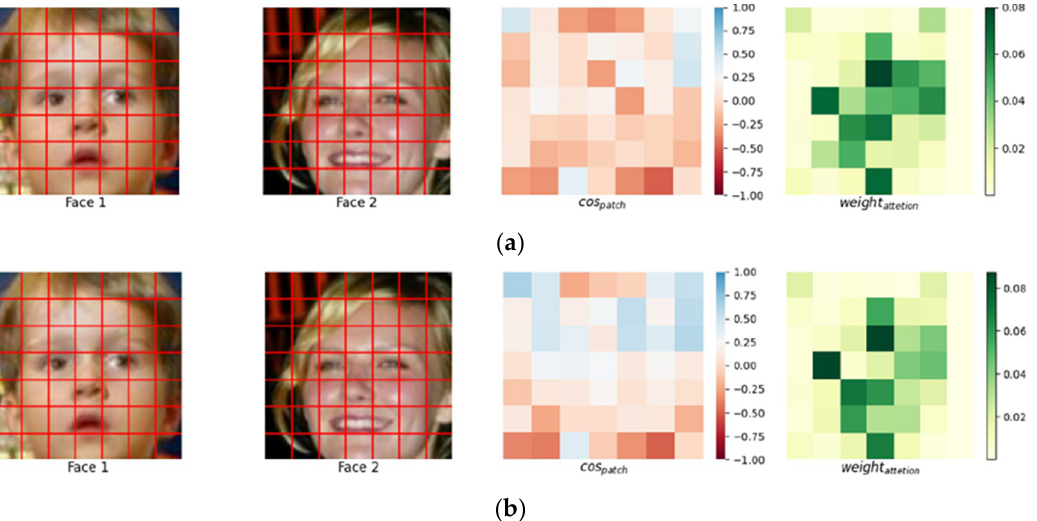
Figure 11. Before and after the eye-based targeted attack. ( a ) Visualization of the features of different faces. ( b ) Feature visualization of different faces after the targeted attack.